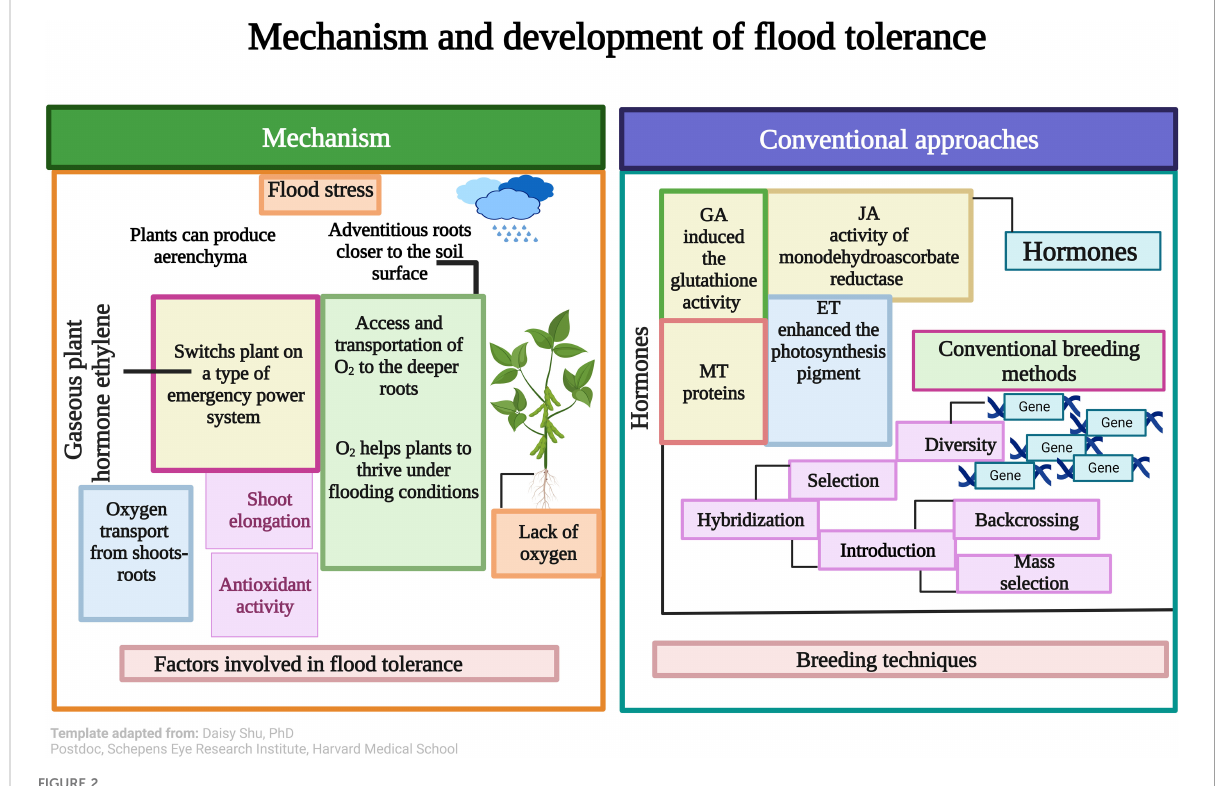
FIGURE 2 Soybean counters fl ooding stress by using adventitious roots and aerenchyma. Besides this gaseous hormone, ethylene (ET) causes the plant to switch to an emergency power system. Hormones mitigate plant growth under fl ood stress via increasing chlorophyll contents, protein, synthesis, etc. Conventional breeding methods are powerful tools for developing fl ood tolerance in soybean. This Figure is created with Biorender.com. (Template adapted from: Daisy Shu, PhD Postdoc, Schepens Eye Research Institute, Harvard Medical